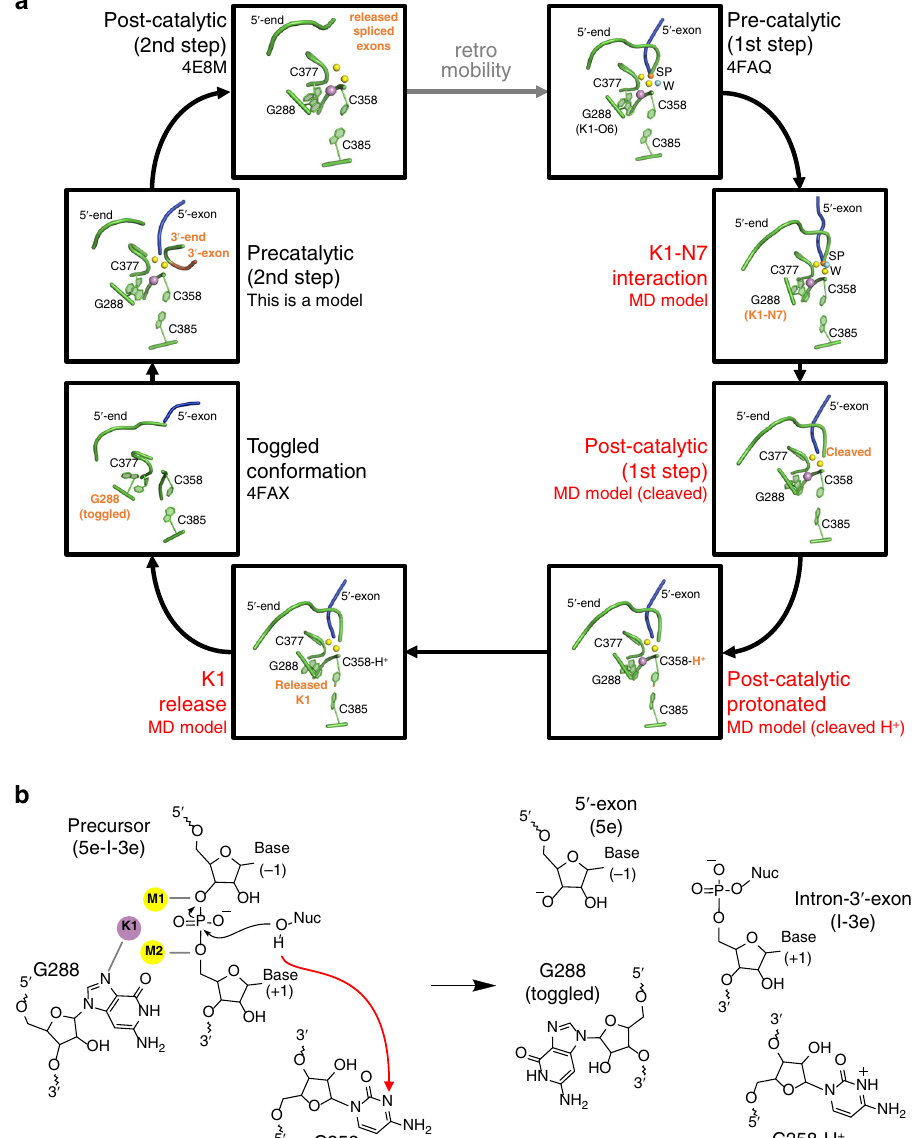
Fig. 7 Revised group II intron splicing cycle. a Snapshots of the intron active site derived from the crystal structures and the MD simulations. In the pre- catalytic state, which corresponds to the pre-hydrolytic state of the fi rst step of splicing, a water molecule (light blue sphere, W) or the 2 ′ -OH of a bulged adenosine are poised for nucleophilic attack on the scissile phosphate (orange sphere, SP) (PDB id. 4FAQ). In this state, the intron established the K1 – N7 G288 interaction, and the nucleophile cleaves the intron-5en junction. Immediately after hydrolytic cleavage, the proton released by the nucleophile initially to the bulk solvent is shuttled to C358 in the catalytic triad. C358 protonation favors release of the metal ions cluster and toggling of J2/3 junction (PDB id. 4FAX). This conformational rearrangement likely prompts the release of the products of the fi rst step of splicing, subsequent rearrangement of D6, and reverse toggling of J2/3 to reconstitute the active site and align second step reactants. Finally, cleavage of intron-3e junction leads to the release of free linear intron (PDB id. 4E8M) and spliced exons. The free intron is still an active ribozyme, which can retrotranspose into target genomic DNA and re- initiate a new splicing cycle (dashed gray arrow). Relevant intron motifs are shown as cartoon representations in green. The 5e is in blue, the 3e in brown. K1 is shown as a violet sphere, M1 and M2 as yellow spheres. K2 is not shown for clarity. Intron states described in this work are labeled red, and differences between consecutive panels are indicated as bold orange labels. b Sketches of the intron active sites corresponding to the precatalytic state (with K1 – N7 interaction, left) and to the K1 release and toggling (right) drawn in the same style as in Fig. 1a. For clarity, only the 5 ′ -splice site is represented. The red dotted arrow indicates the proton transfer pathway from the nucleophile (Nuc) to N3 C358